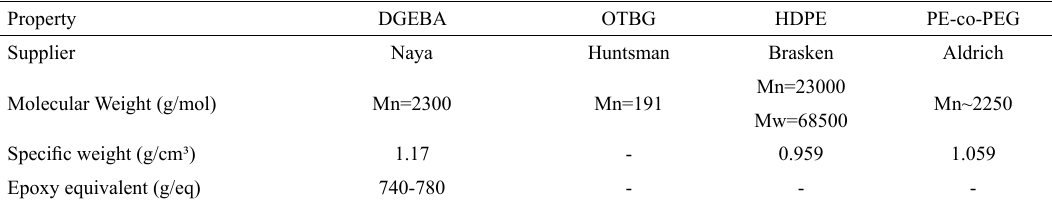
Table 1. Properties of materials used in this work Property